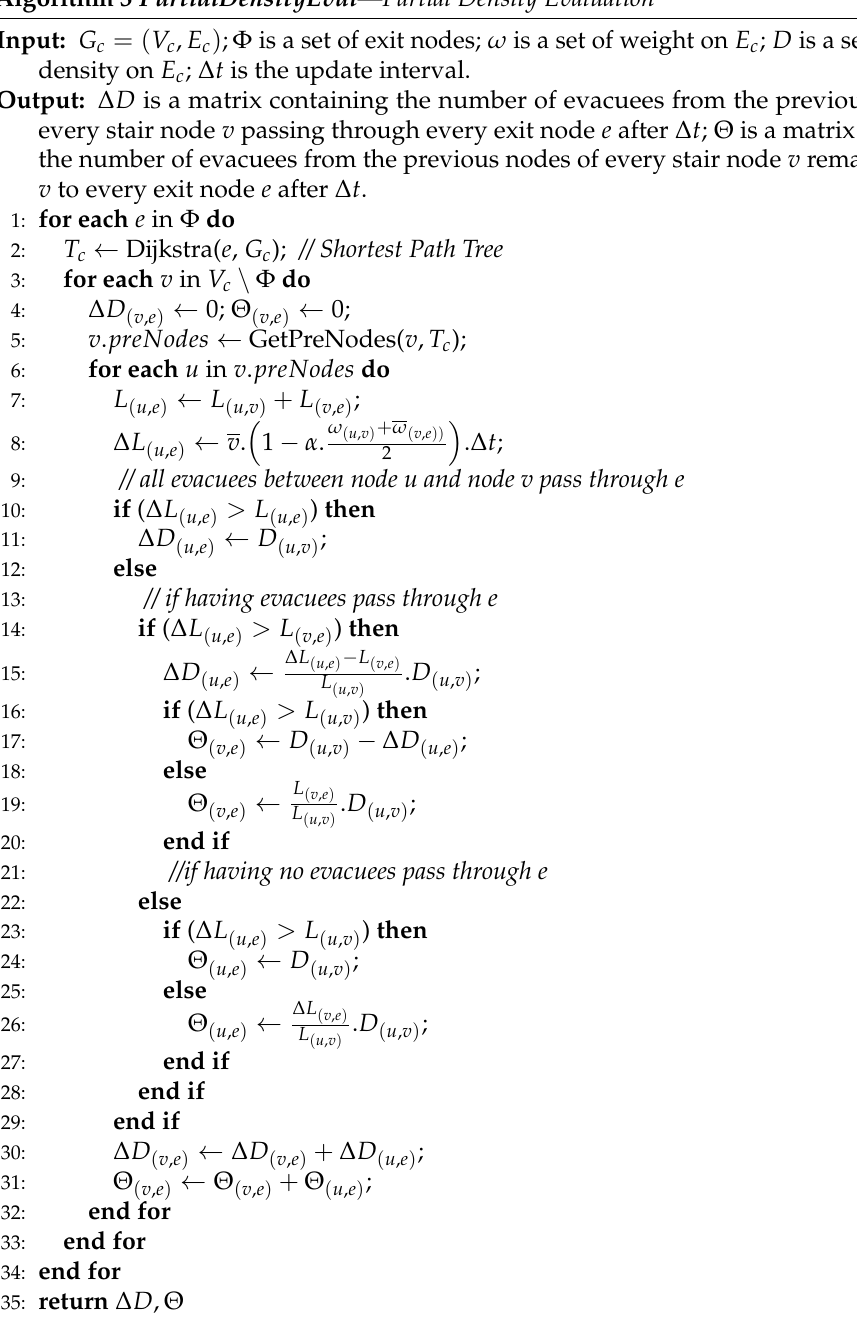
Algorithm 3 PartialDensityEval — Partial Density